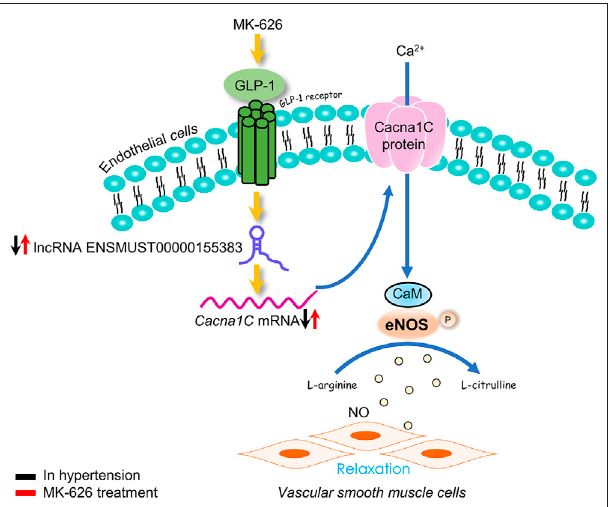
FIGURE8| The proposedmolecularmechanism forthebene fi cial effect of sitagliptin on endothelial function in hypertension. The eNOS activity was suppressed in hypertension. Elevation of GLP-1 by MK-626 stimulated eNOS activation via restoring cytosolic Ca 2+ concentration through lncRNA ENSMUST00000155383/Cacna1c,leadingtotheimprovementofendothelial function in